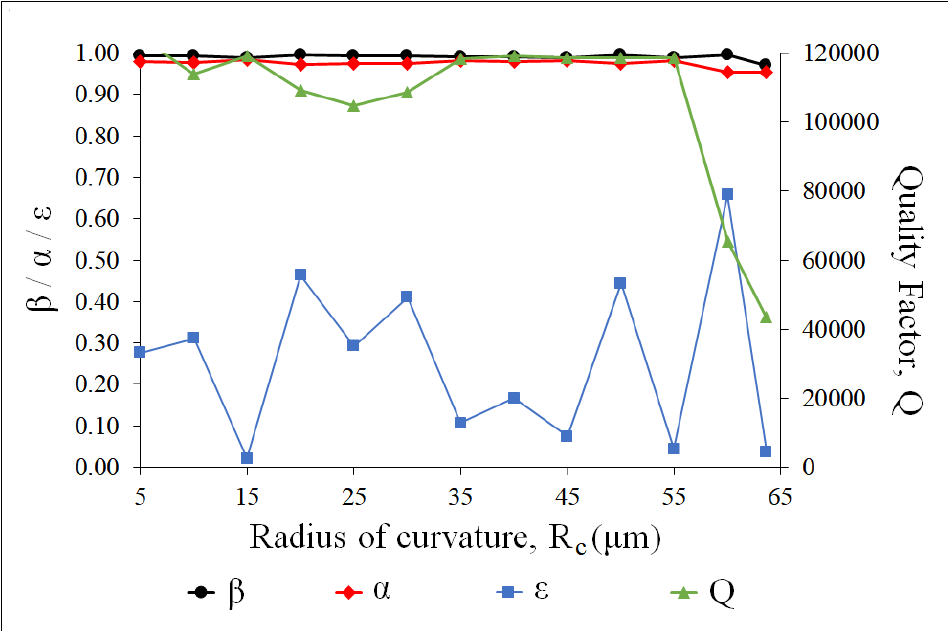
Figure 10. Optical parameters for the rotated RCSS microresonators of the varying radius of curvature R c . The rotation angle is 45 ◦ with respect to the feed waveguide around the coupling point. The coupling region is in a central corner of the